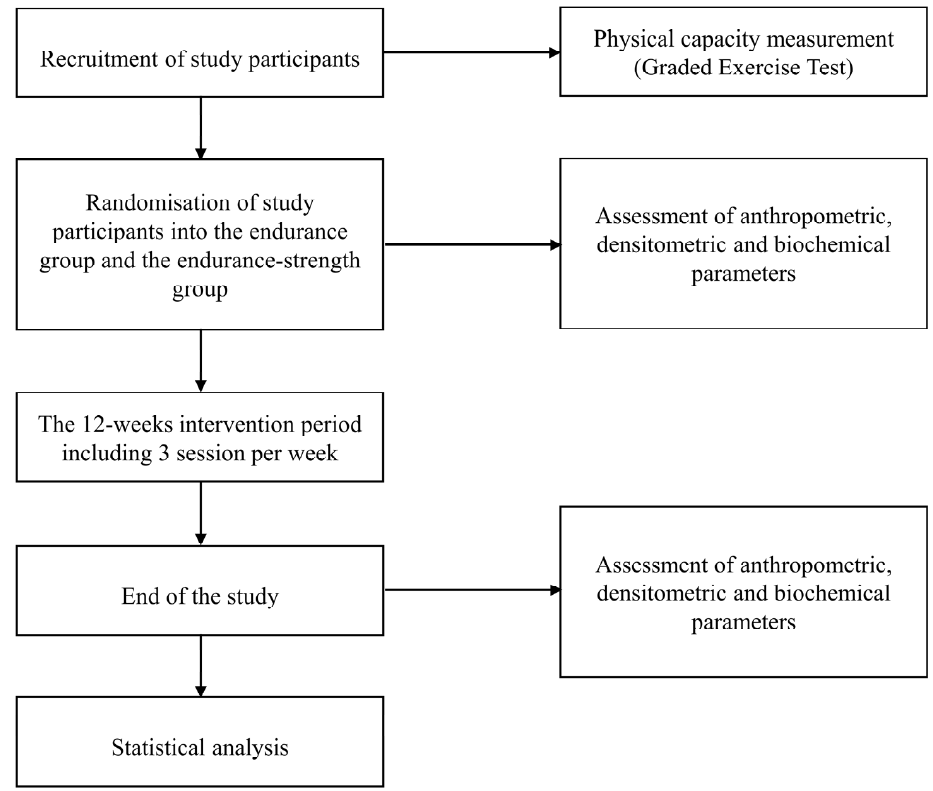
Figure 1. Scheme of the study.